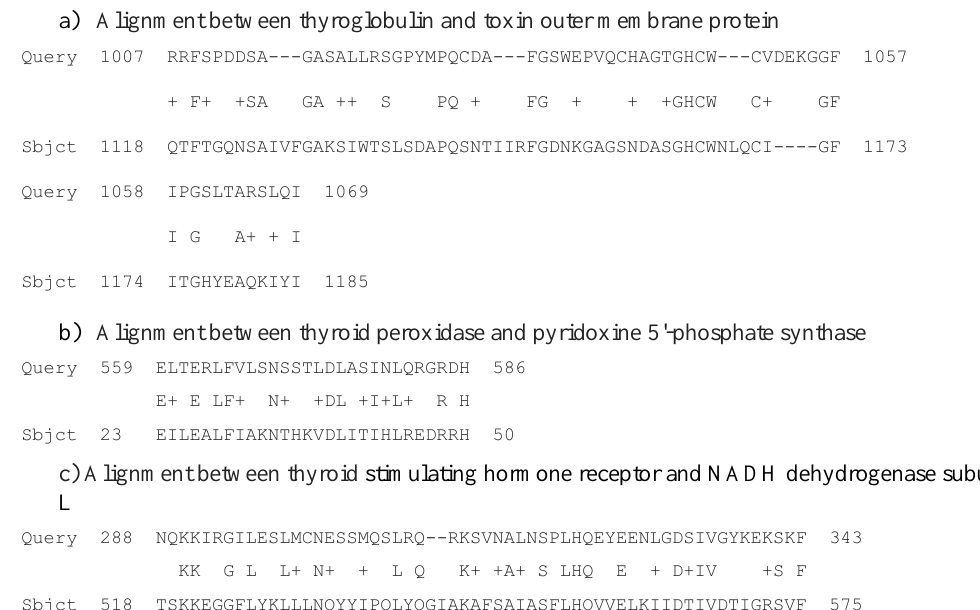
Figure 5. Main putative conserved domains detected by aligning thyroglobulin, thyroid peroxidase, and thyroid stimulating hormone receptor with H. pylori proteins. “Query”: Amino acid sequence of the human proteins. “Subject”: Amino acid sequence of the bacterial protein present in the data base. “ + ” indicates that the amino acid in the sequence “query” and that one in the sequence “subject” are similar from a chemical-physic point of view. The numbers in the sequence represent the initial and final positions of the amino acid